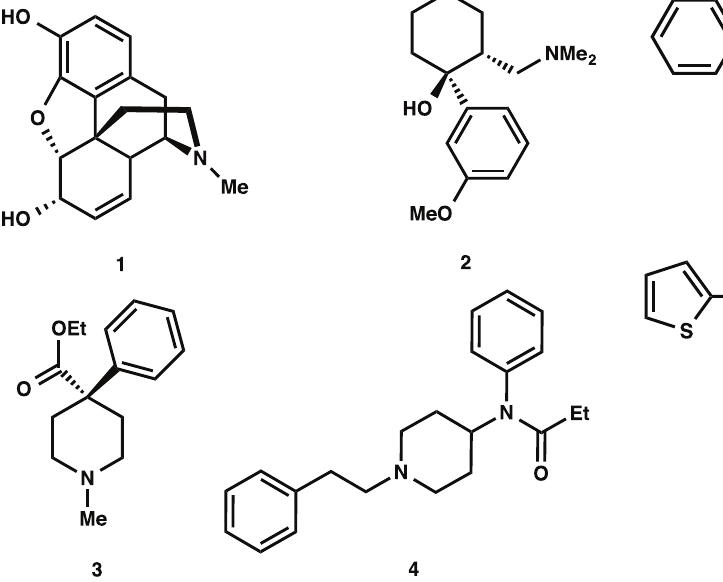
Figure 1. Various commonly administered opioids: (1) mor- phine, (2) Tramadol, (3) Demerol, and (4) fentanyl.